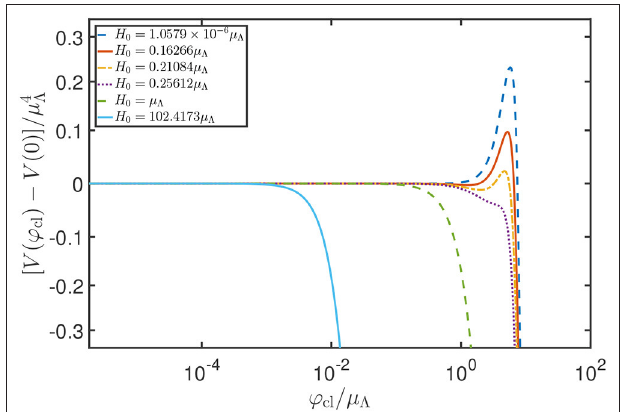
FIGURE 4 | The one-loop RGI effective potential for the full SM in de Sitter space with ξ 0 at the electroweak scale, in units of the instability scale = (2.25), using the optimized scale choice (3.28). The x axis is given by the field ϕ ( M t ). The disappearance of the renormalized at the physical top mass, ϕ cl ≡ potential barrier at large Hubble rates can be traced back to the RG running of the non-minimal coupling ξ . Figure taken from Markkanen et al.